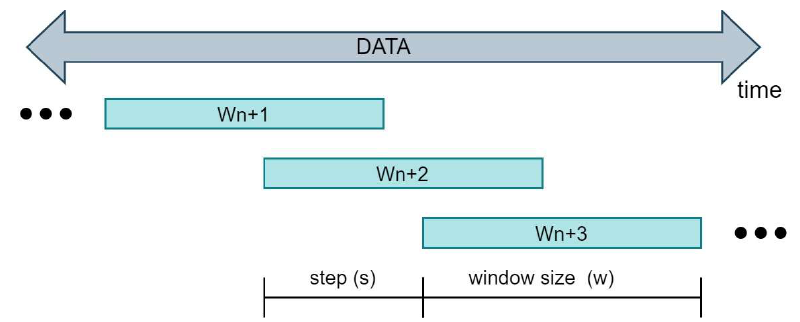
Figure 12. Sliding windows